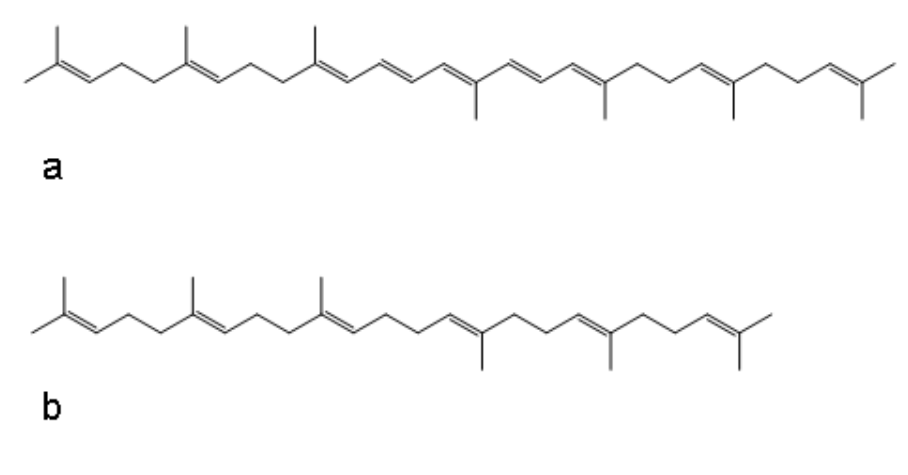
Figure 4. Structures of (a) zeta-carotene and (b)